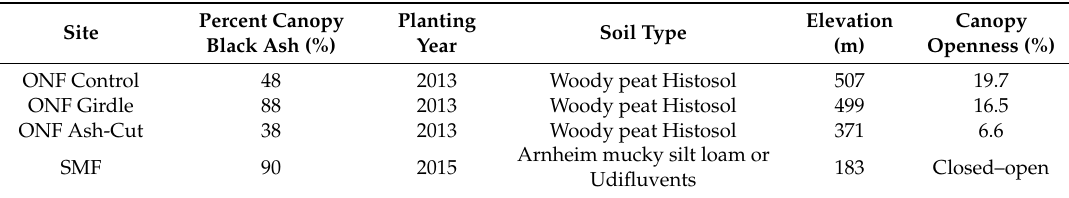
Table 1. Treatment and planting years, soil type [18], elevation, and canopy characteristics on the Ottawa National Forest (ONF) and Superior Municipal Forest (SMF) study wetlands.